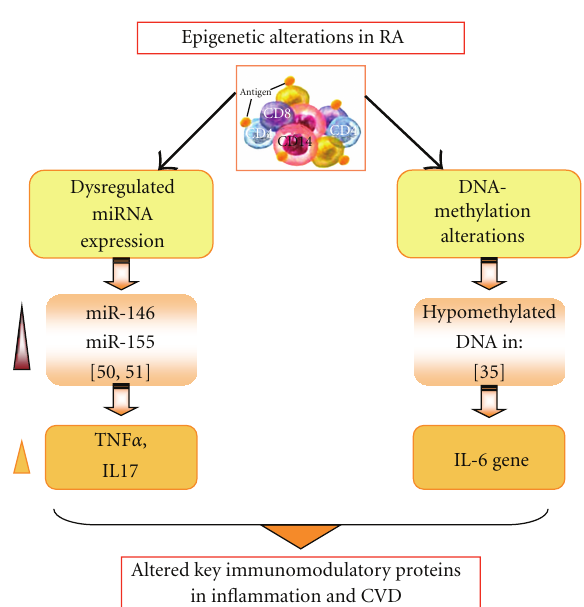
Figure 2: Epigenetic alterations in RA and potential pathogenic contributions to inflammation and CVD. See the text for further